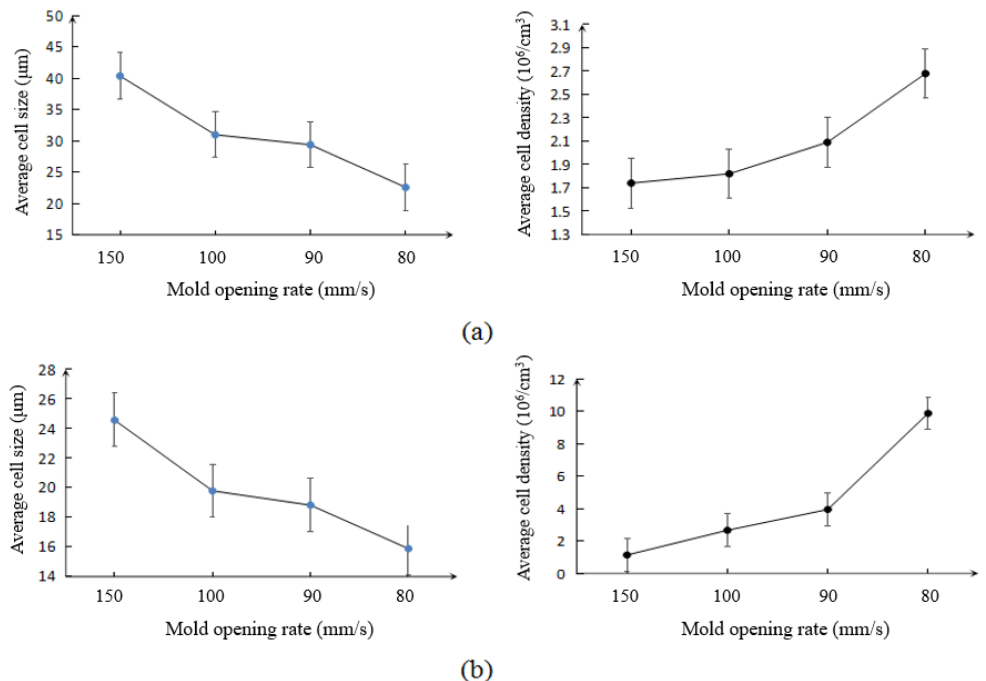
Figure 4. Average cell size and cell density vs. mold opening rate in ( a ) pure PLA foams and ( b ) PLA– nanoclay foams measured at the near the gate of the